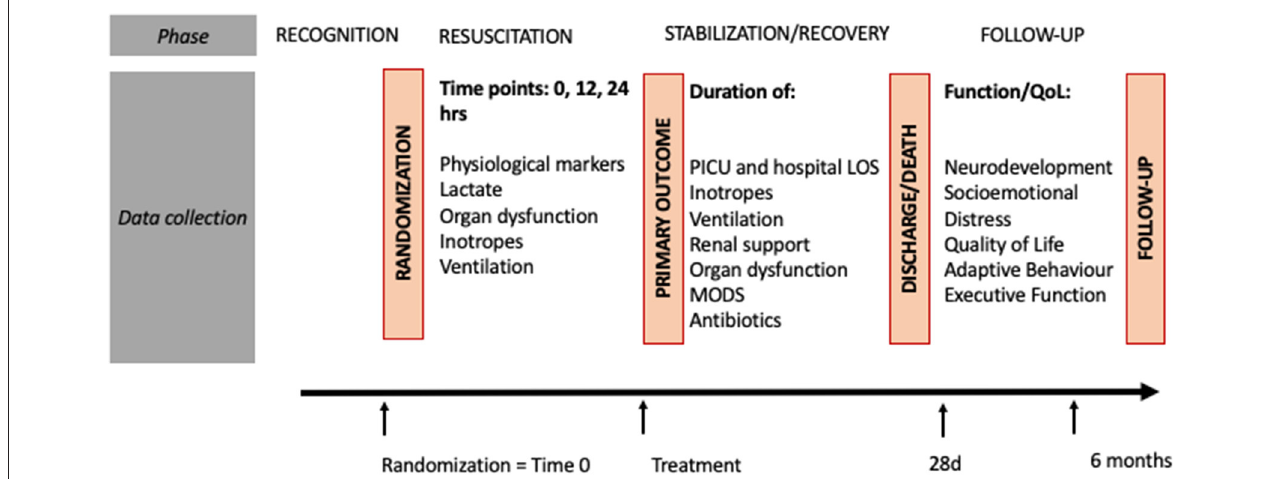
FIGURE 2 | Study procedures. ASQ, ages and stages; BRIEF, paediatric Behavior Rating Inventory of Executive Function; FSS, functional status score; LOS, length of stay; MODS, multiple organ dysfunction syndrome; PICU, paediatric intensive care unit; POPC, Paediatric Overall Performance Category; QoL, quality of